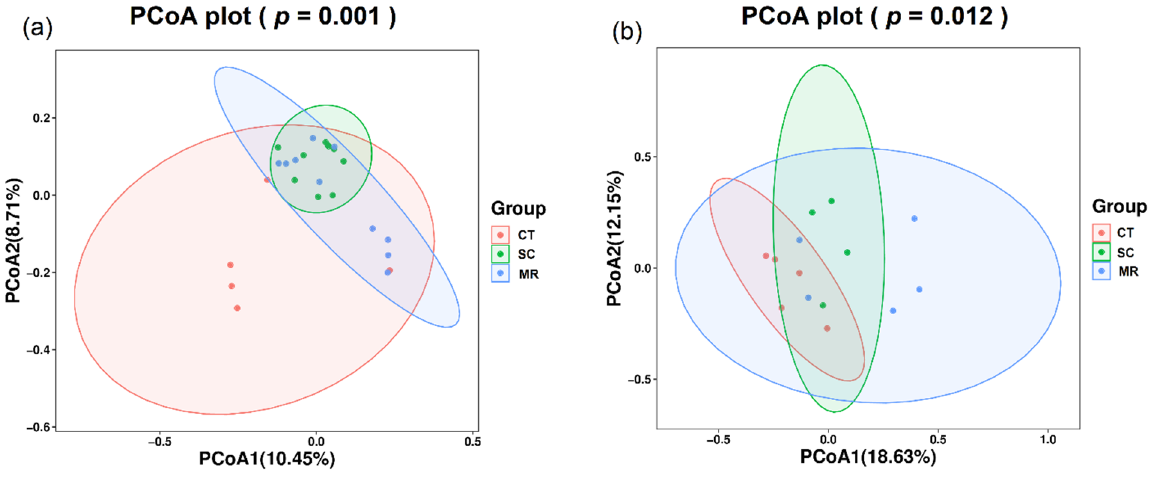
Figure 3. Principal coordinates analysis (PCoA) with unweighted UniFrac distance of ( a ) bacterial and ( b ) fungal community composition. Different colored ellipsoids represent different treatments.